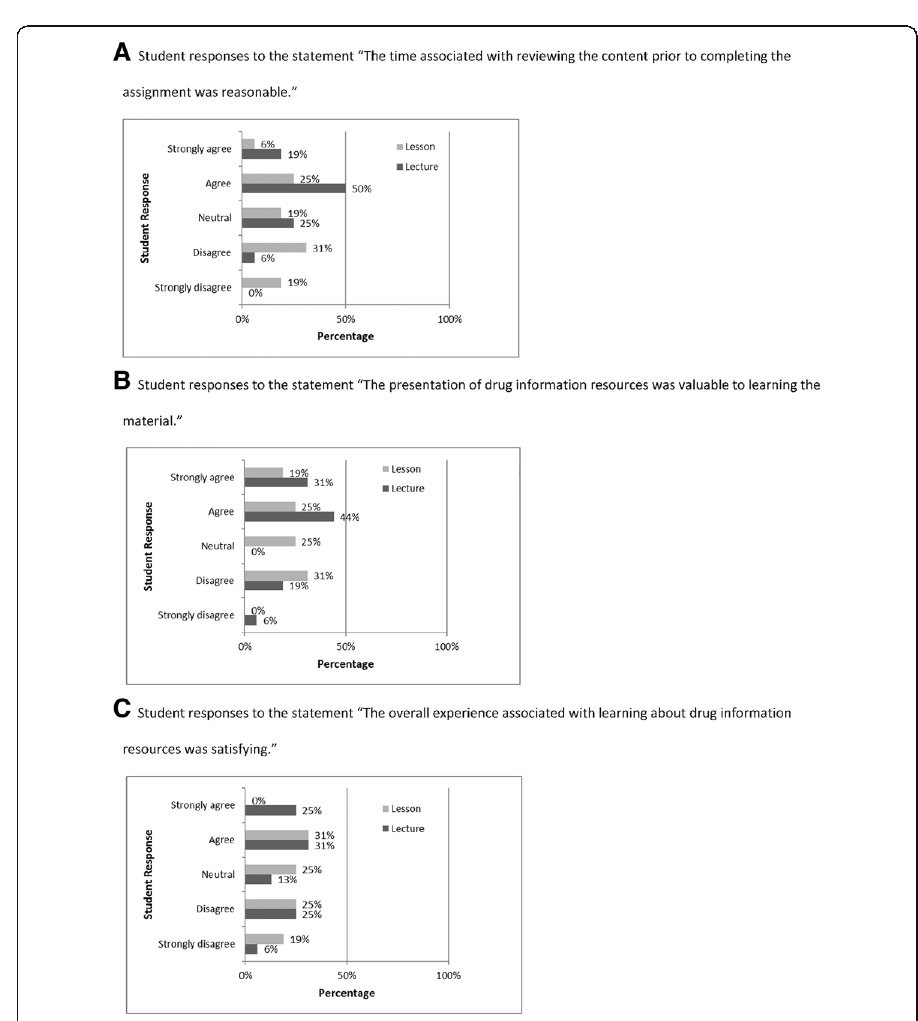
Fig. 2 Student opinion of lesson or lecture educational techniques ( n =